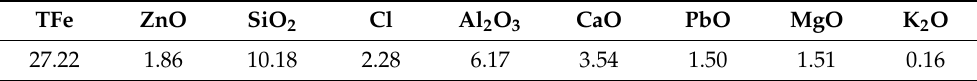
Table 6. XRF analysis of leaching residue (%).